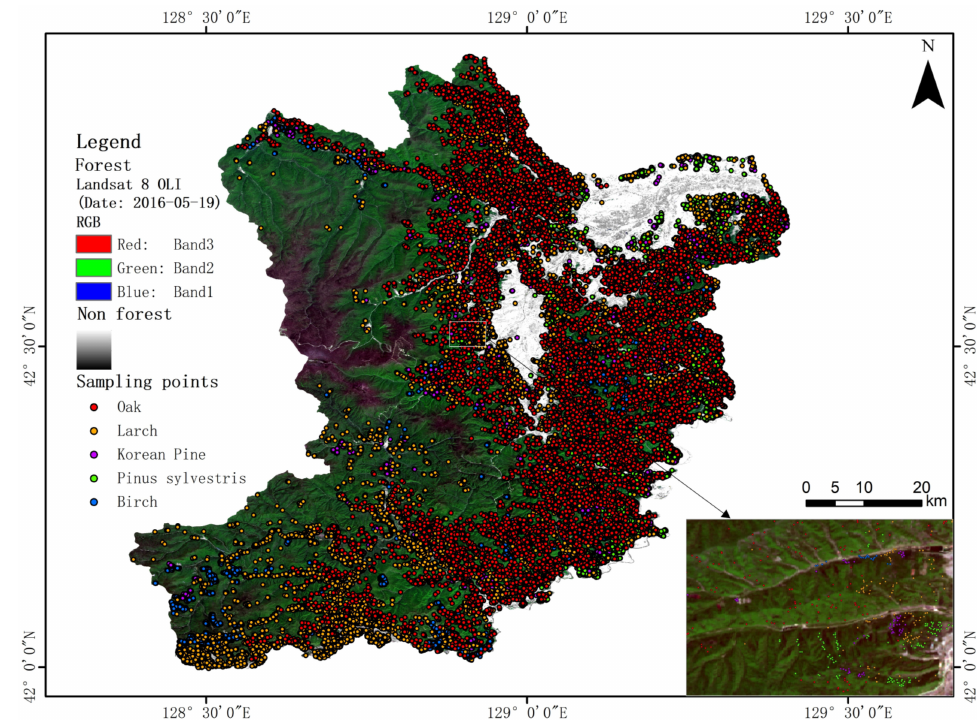
Figure 5. Distribution of sampling point data used in this